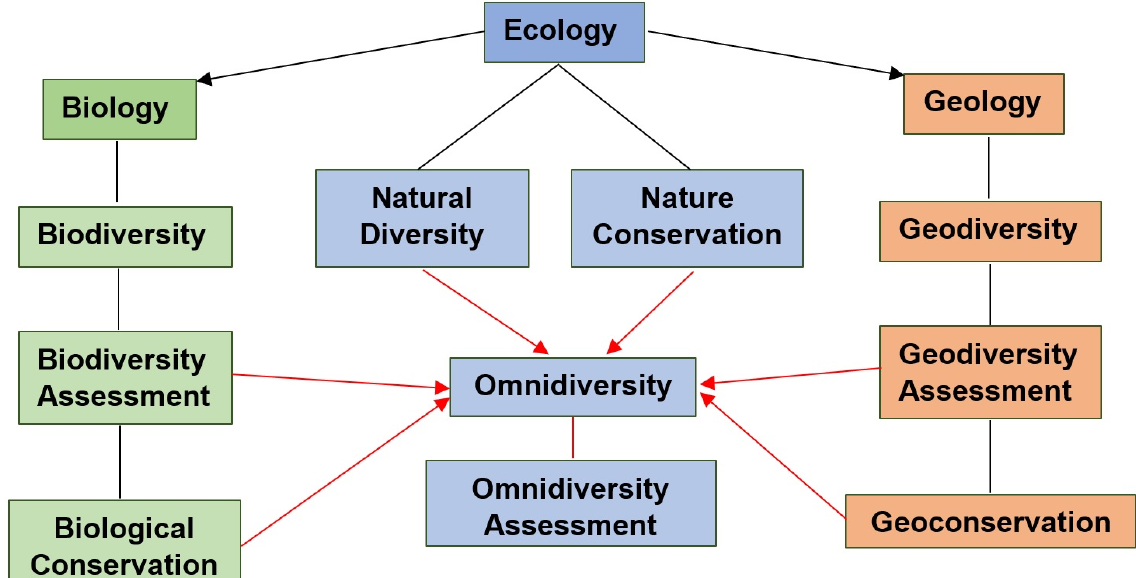
Figure 7. Interconnectedness and relationship of existing terms biodiversity, geodiversity, natural diversity, and conservation to the novel omnidiversity and omnidiversity assessment